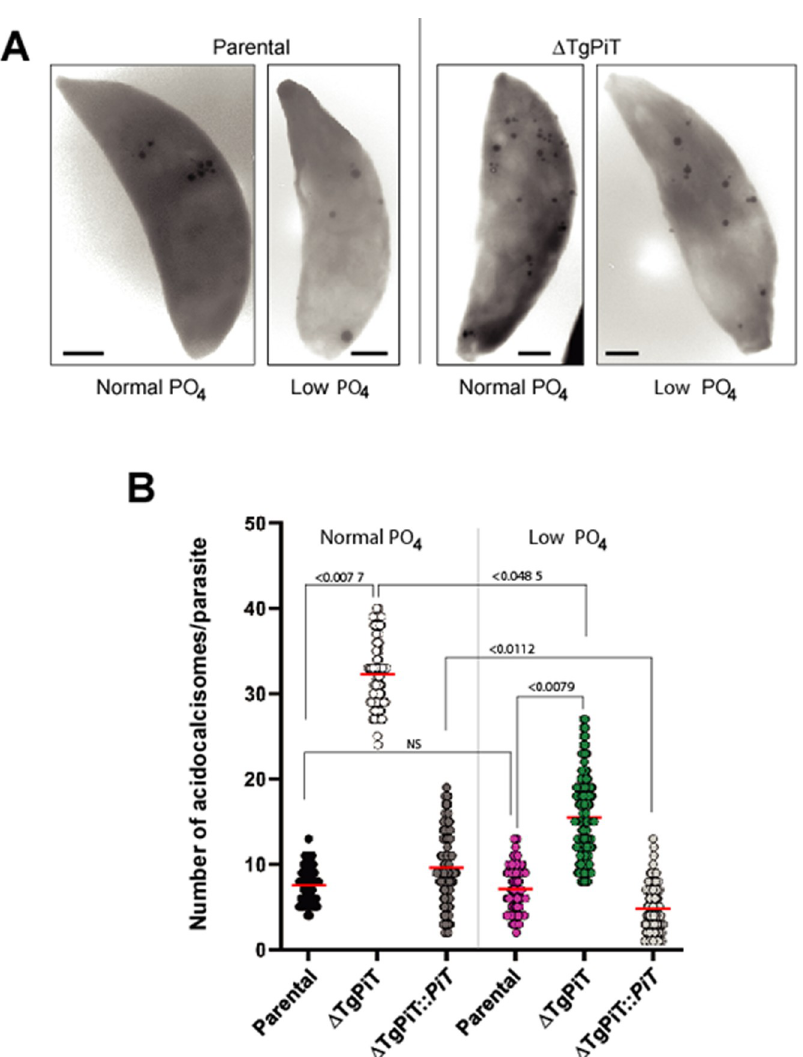
Fig 9. Quantification of acidocalcisomes in Δ TgPiT parasites. A. EM of representative extracellular parental and Δ TgPiT parasites incubated in normal or low PO 4 medium for 24 h and applied to carbon-coated formvar grids before examination at the microscope, showing the abundance of acidocalcisomes in the mutant. B. Dotplot graphs for acidocalcisome number per parasite strain per PO 4 condition (50 parasites observed in 3 independent preparations). p values were calculated using Fisher’s LSD